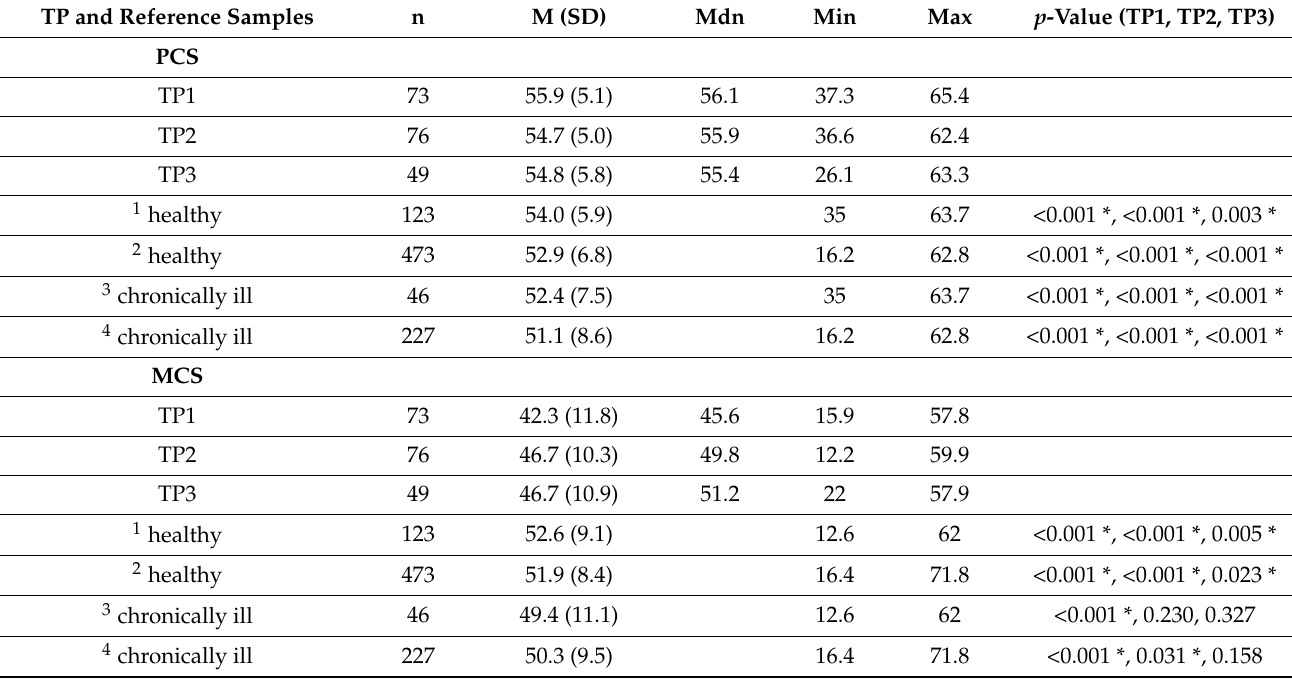
Table 11. Descriptive analysis and Wilcoxon signed-rank test for the PCS and for the MCS of the SF-12 compared to one healthy and one chronically ill reference sample stratified by age.